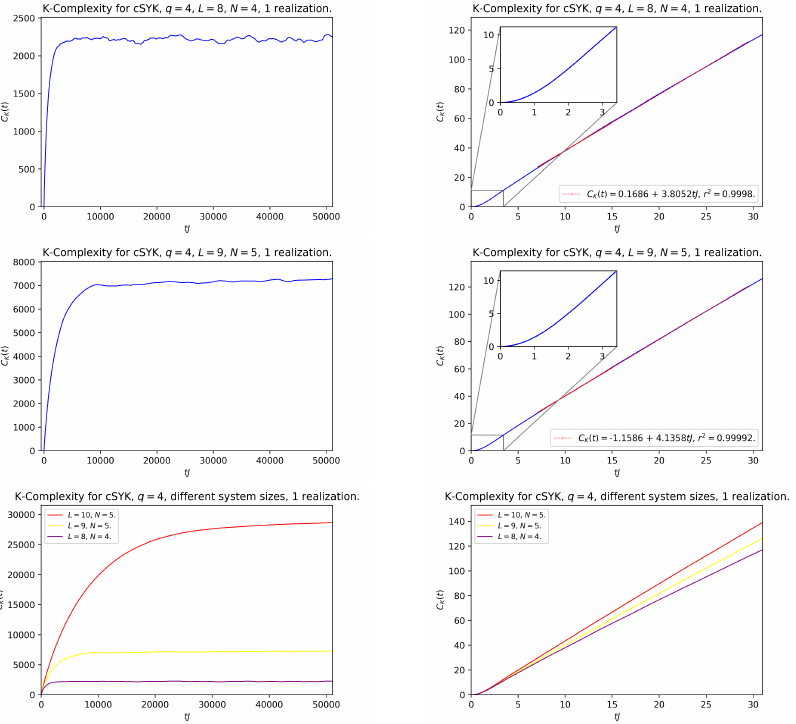
Figure 5 . Results for K-complexity for L = 8 , N = 4 and L = 9 , N = 5 and comparison of results for L = 8 , 9 , 10 . Top row: results for L = 8 ; for exponentially long times (left panel) and for early times (right panel). Note the change in behaviour from very early times (inset) and later times. The value at saturation is near ∼ K = 2415 . 5 . Middle row: results for L = 9 ; for exponentially long 2 times (left panel) and for early times (right panel). The value at saturation is near ∼ K = 7875 . 5 . 2 Bottom row: comparison of results for L = 8 , 9 , 10 for exponentially long times (left panel) and for early times (right